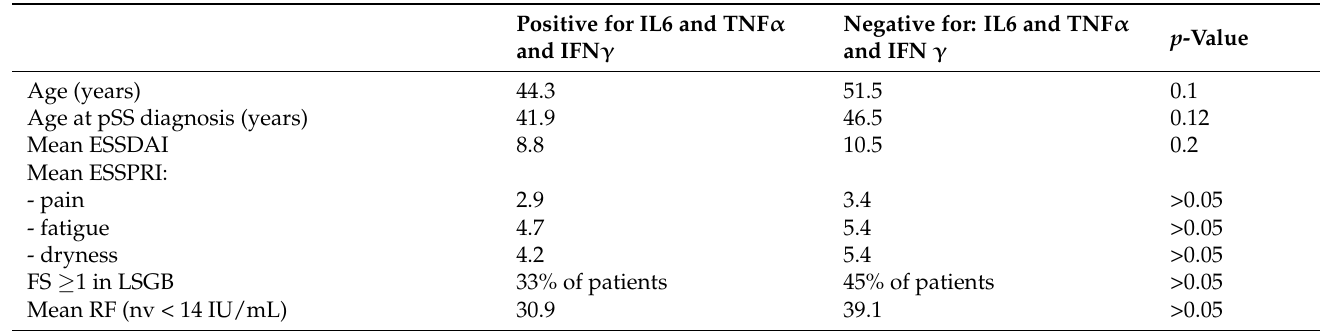
Table 4. Comparison of pSS patients with IL6, TNF α and IFN γ presence demonstrated with a group of negative patients in terms of their